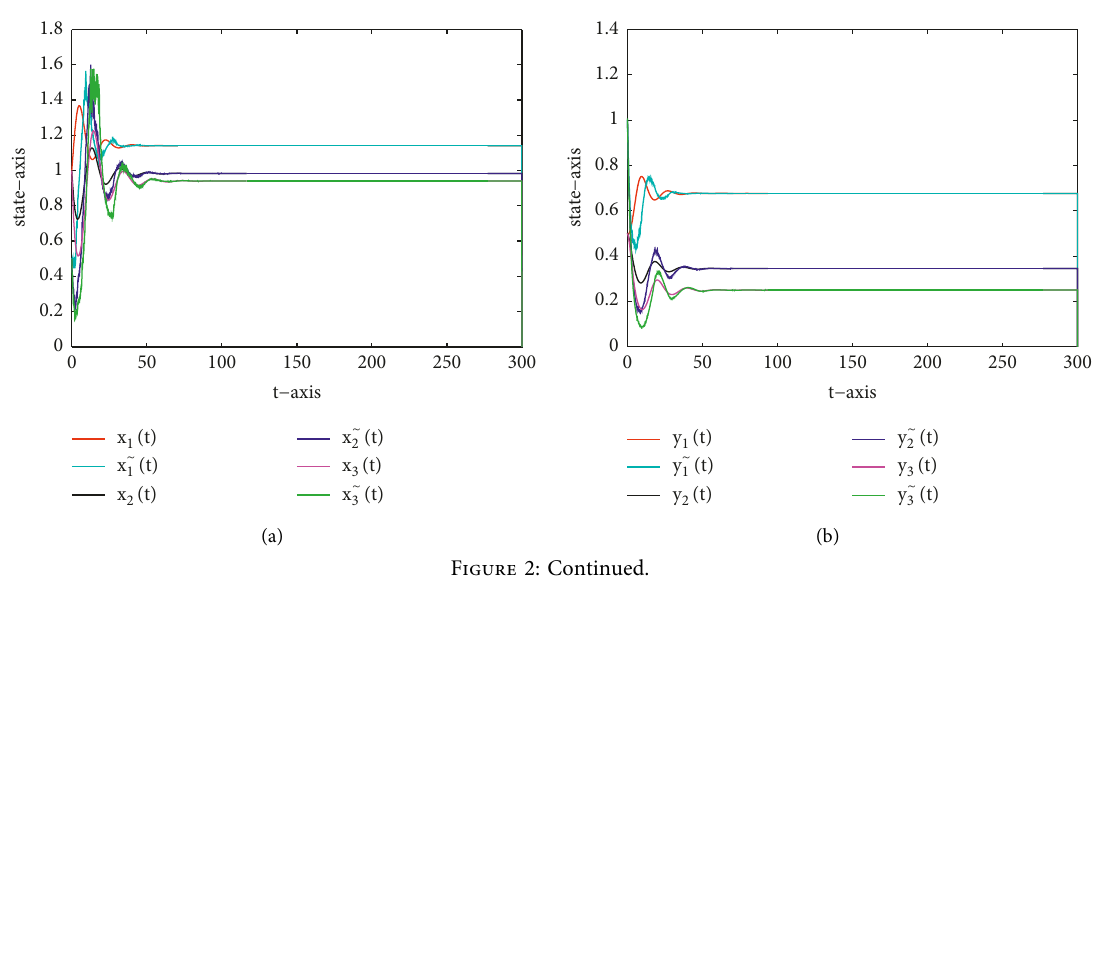
( t ) and y ∼ ( t ) , i � 1 , 2 , 3 i i